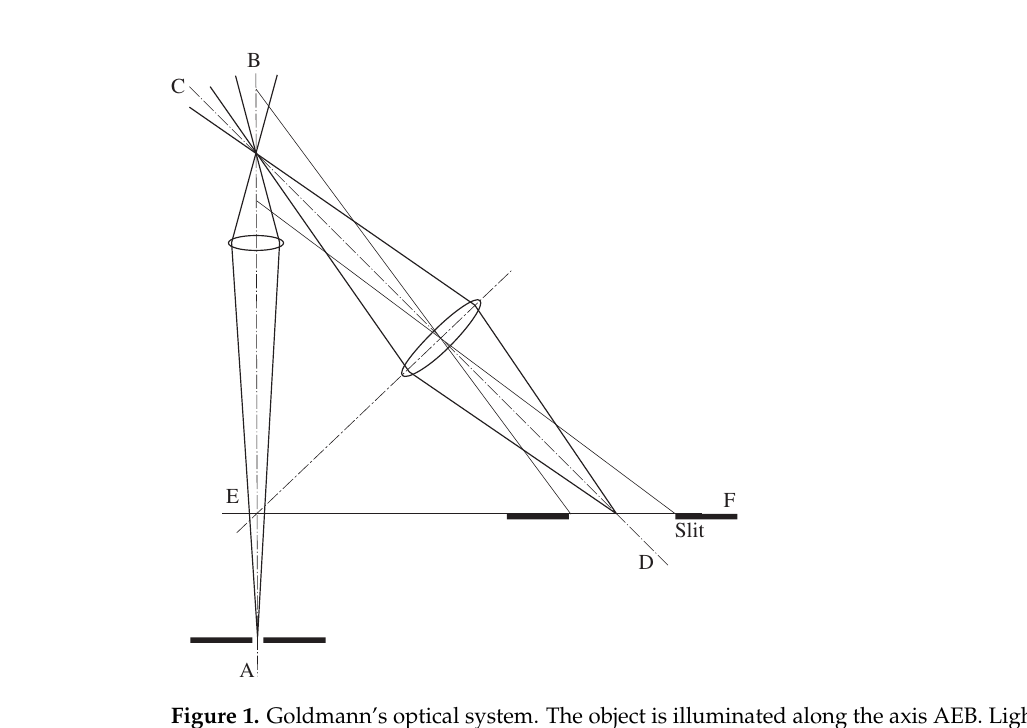
Figure 1. Goldmann’s optical system. The object is illuminated along the axis AEB. Light is detected along the off-axis path